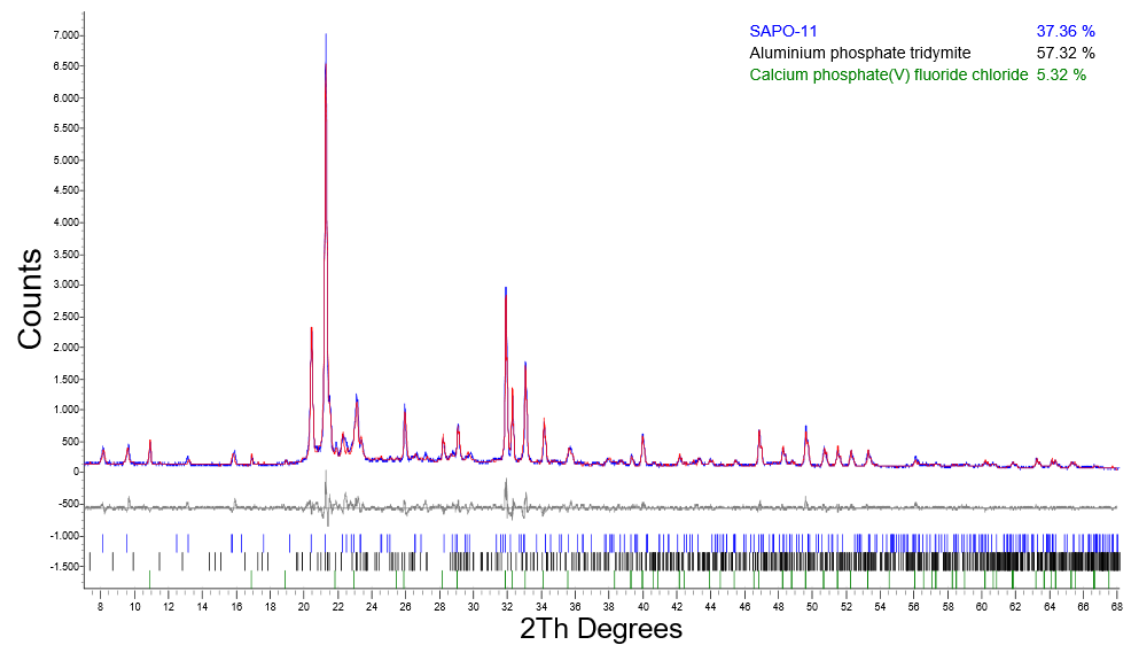
Figure A5. Rietveld refinement plot for 72/SHR0.5: the vertical lines provide the positions of all possible Bragg reflections for the aluminum phosphate(V) phases (database_code-ICSD 88566), calcium phosphate(V) fluoride chloride (database_code-ICSD 203026), and structure of zeolite type AEL (database_IZA). The values of the standard agreement indices are Rp—8.36, Rwp—10.77, Rexp—6.33, GofF—1.70.